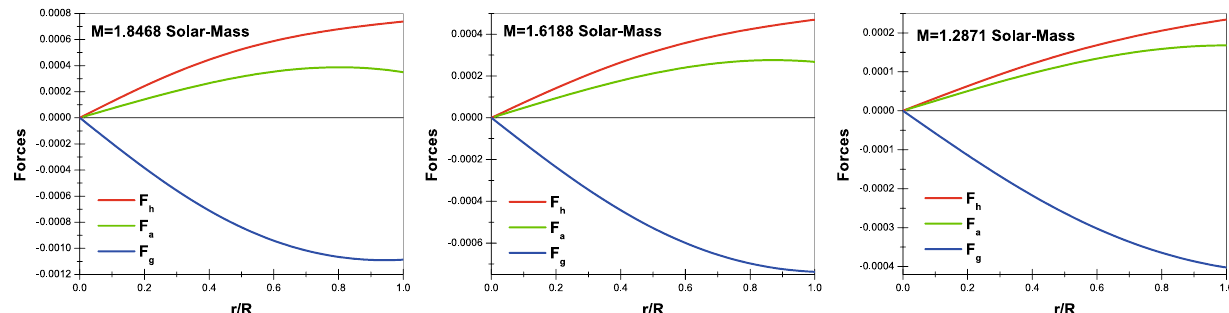
Fig. 4 Figures show forces (hydrostatic, F h ,anisotropic, F a , andgrav- itational, F g ) for three different values of the mass M versus the nor- malized radial coordinate r / R . Left Panel : Forces for M = 1 . 8468 M (cid:9) against r / R . Middle Panel : Forces for M = 1 . 6188 M (cid:9) against r / R . Right Panel : Forces for M = 1 . 2871 M (cid:9) against r / R . All these plots